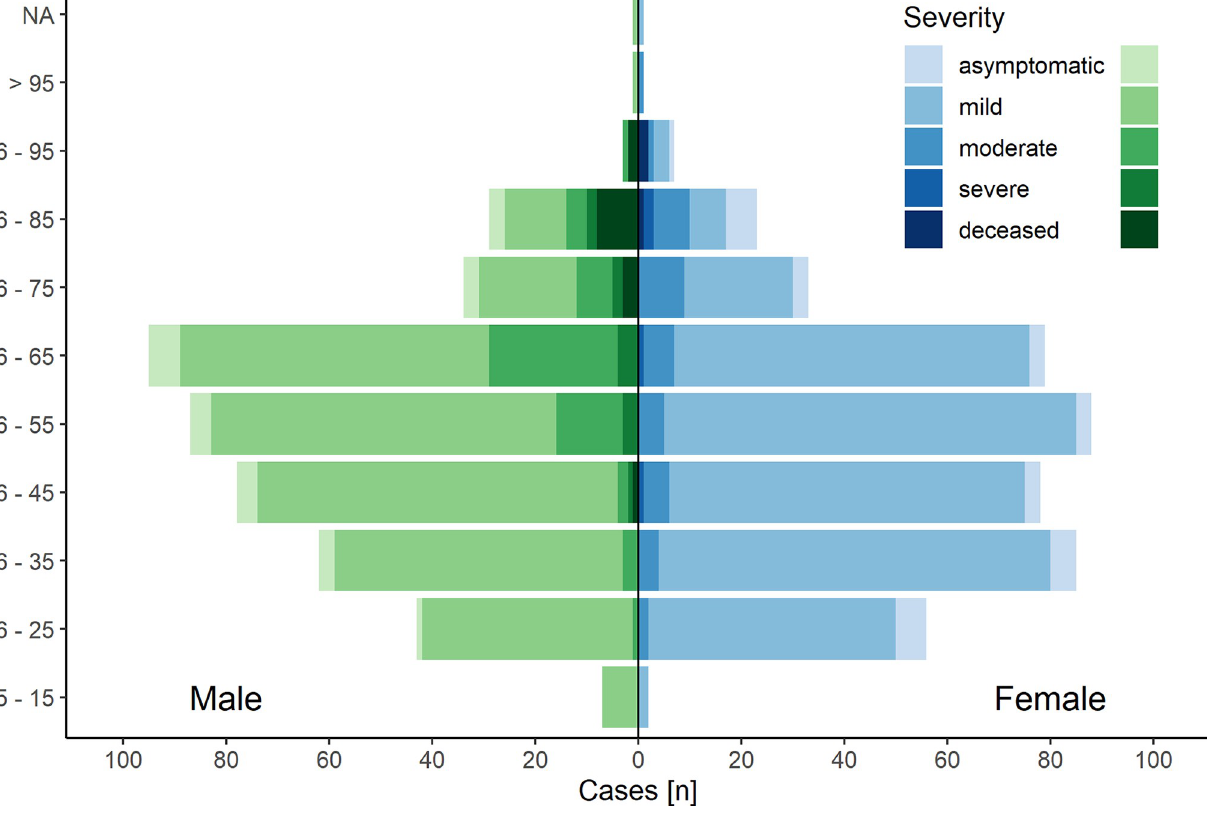
Fig 2. Severity and age distribution. Patients with COVID-19 stratified by age and sex. Female n = 453; Male n = 441 The left-hand side (green) shows male and the right-hand side (blue) female participants. The shades of color represent different level of disease severity. The severity of disease increases with darker shades of color. Further details on the group´s composition can be found in Tables 1 and